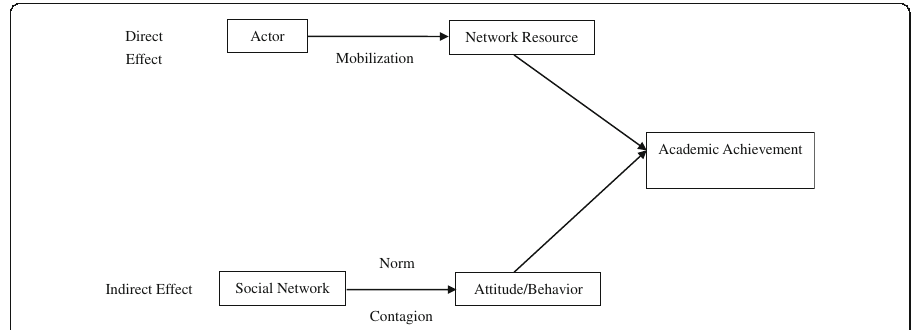
Fig. 1 Two mechanisms by which peer social capital influences academic